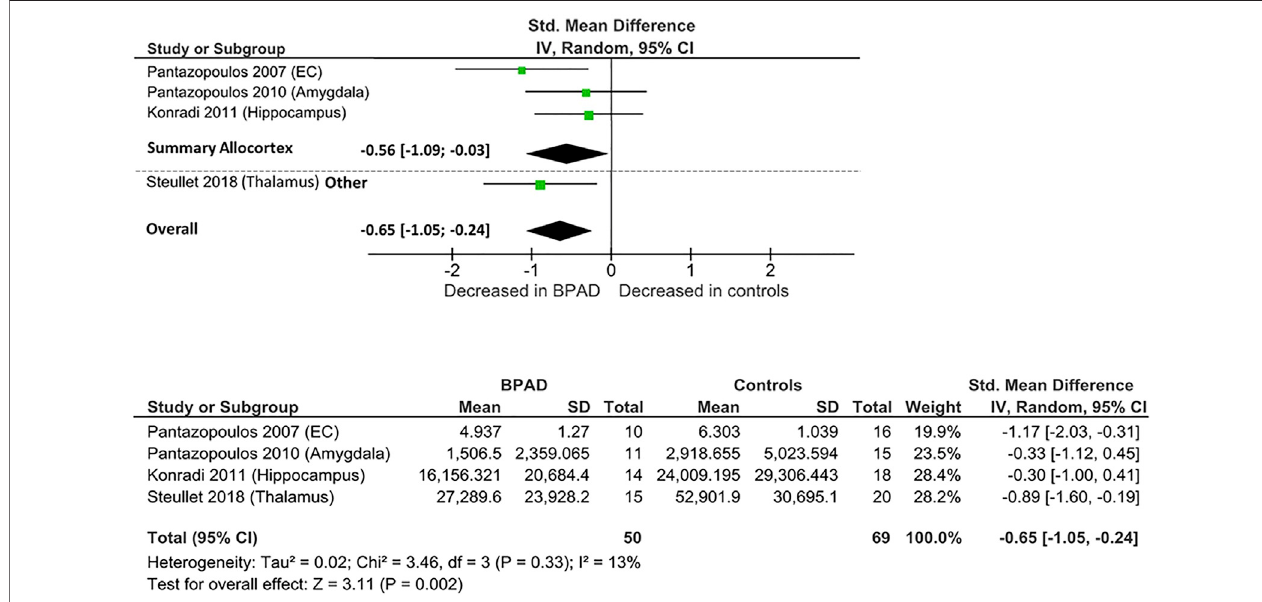
FIGURE 2 | Forest plot on PV-INs total number: allocortical areas, others, and overall comparison.